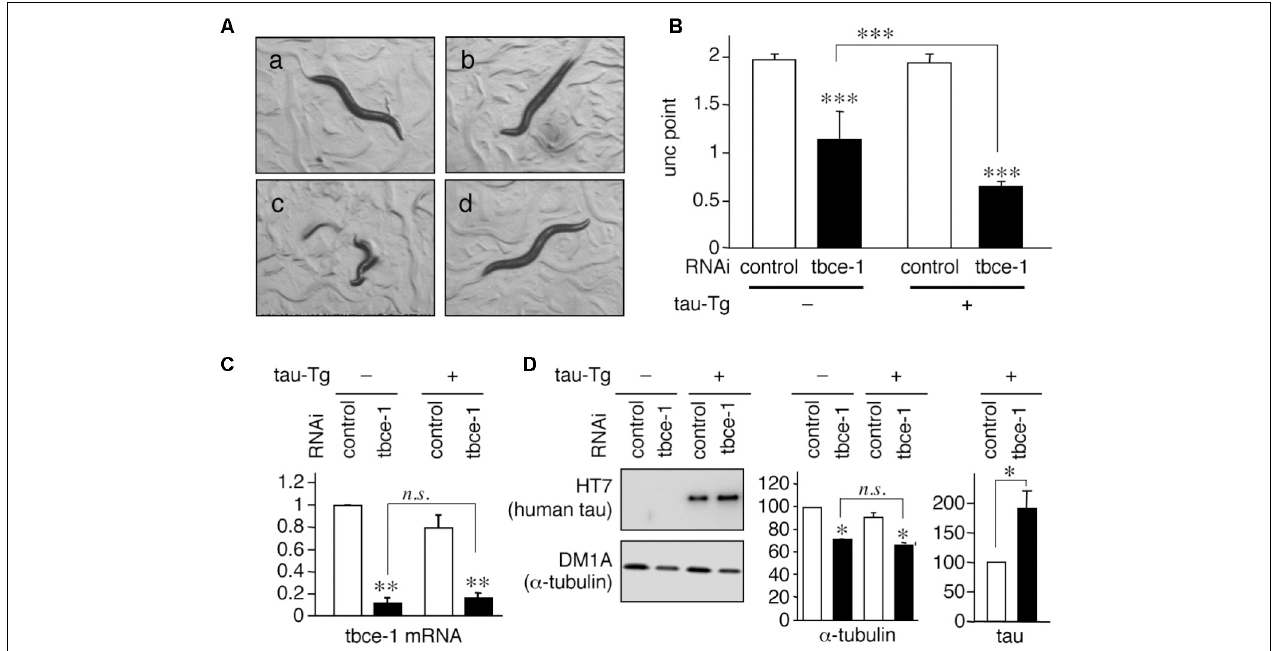
FIGURE 2 | Tau expression enhances uncoordinated movement induced by tbce-1 gene knock down. (A) WT4R(L)-Tg/rrf-3 (a–c) and Mock-Tg/rrf-3 worms (d) were grown on L4440::T (a; control) or L4440:: tbce-1 ( b–d ; tbce-1 ) RNAi plates from embryo to 3 days after hatch. Rrf-3 background worms grown on tbce-1 RNAi plates showed Unc (b) or a frequent burst phenotype (c) . (B) The severity of Unc was assessed as described in Materials and Methods section. Average scores of three independent experiments are shown (means ± SEM, n = 3). WT4R(L)-Tg/rrf-3 worms showed a significantly higher sensitivity to tubulin chaperon knockdown. (C) The levels of tbce-1 mRNA were quantified by quantitative real time RT-PCR (means ± SEM, n = 3). tbce-1 mRNA is suppressed to less than 25% compared to controls, regardless of tau expression. (D) The levels of tau and α -tubulin were analyzed by Western blotting. The percent expression of control worms is shown (means ± SEM, n = 3). Statistical significance was analyzed by Tukey’s post hoc test ( ∗ p < 0.05 , ∗∗ p < 0.01 , and ∗∗∗ p < 0.001 ) or Student’s t -test ( ∗ p < 0.05 ).